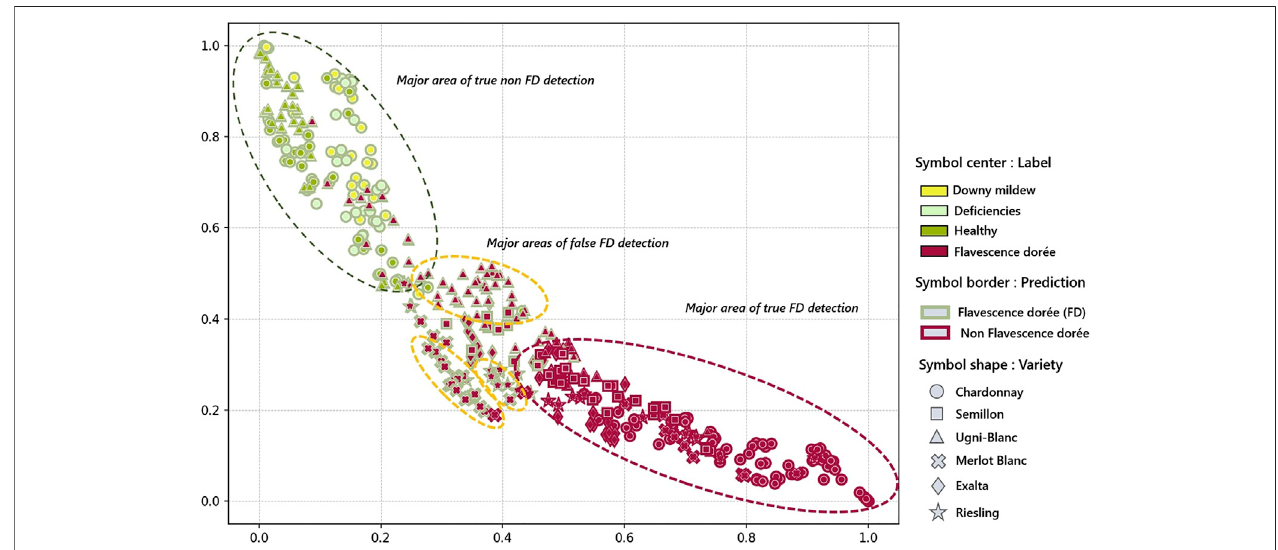
FIGURE 10 | Grape varieties in the model space: UMAP visualization of the embeddings based on an arbitrarily-set seed.